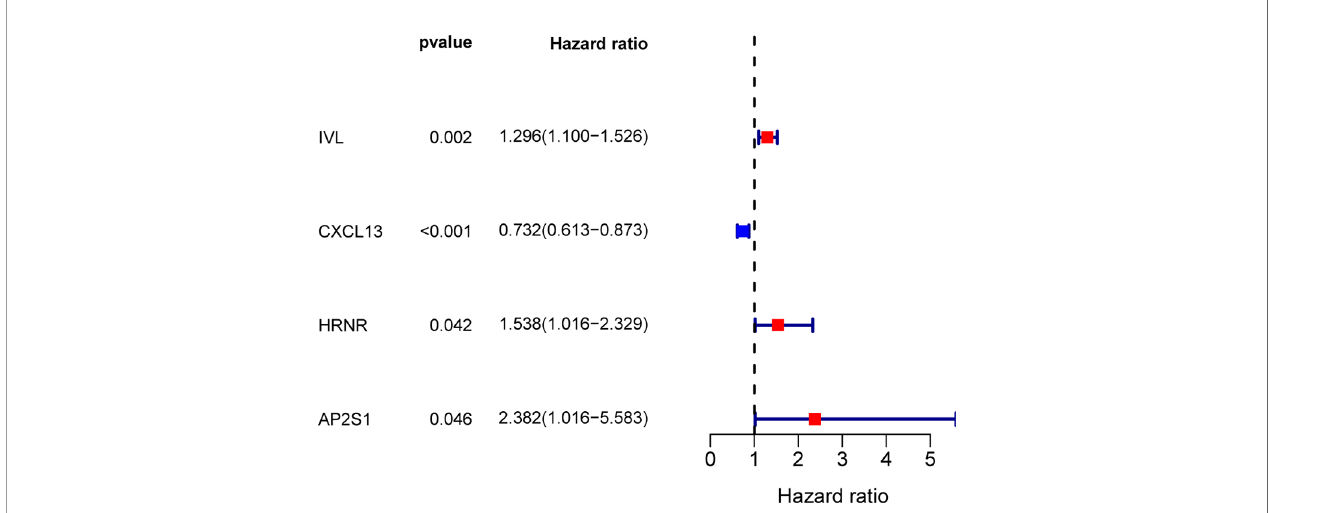
FIGURE 2 | Screening for exosome-related genes associated with prognosis of TNBC patients by univariate Cox regression analysis. Four exosome-related genes were con fi rmed to be associated with patient ’ s OS ( p < 0.05).